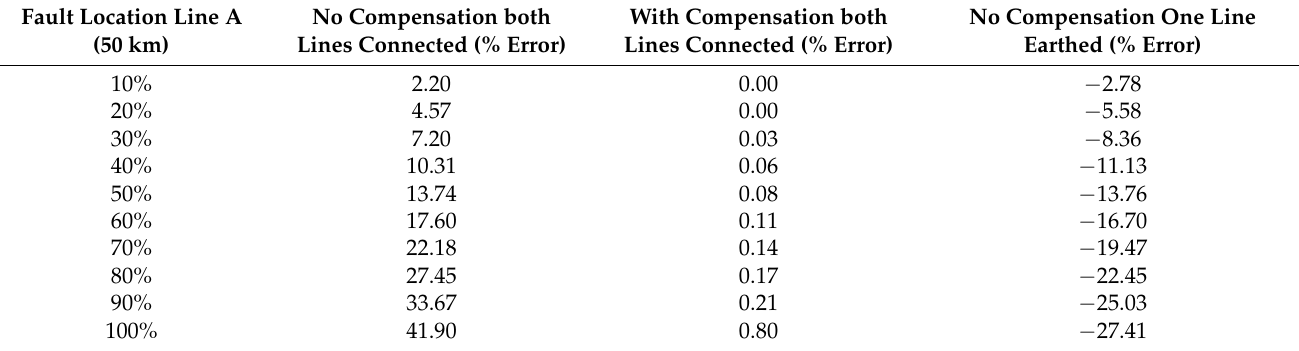
Table 3. Result of simulations for a compensated and uncompensated double-circuit line ( R F = 0 Ω ). Fault Location Line A (50